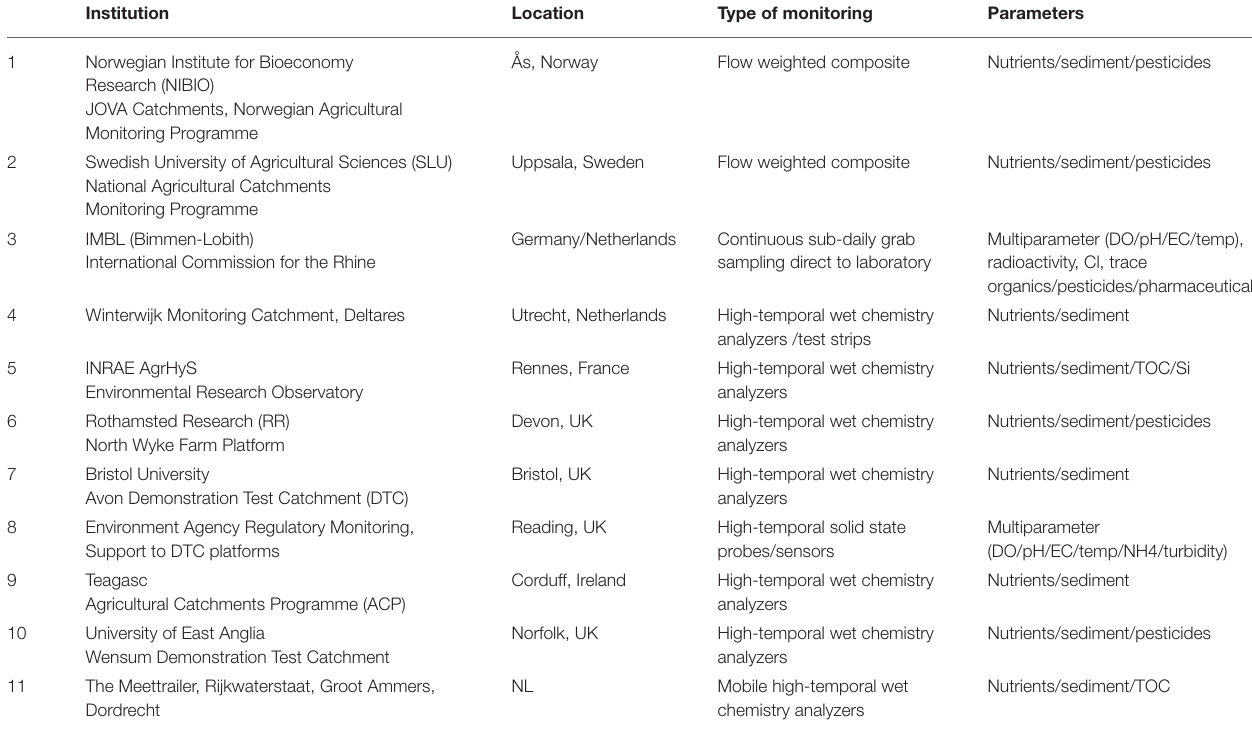
TABLE 1 | Institutions visited using enhanced water quality monitoring